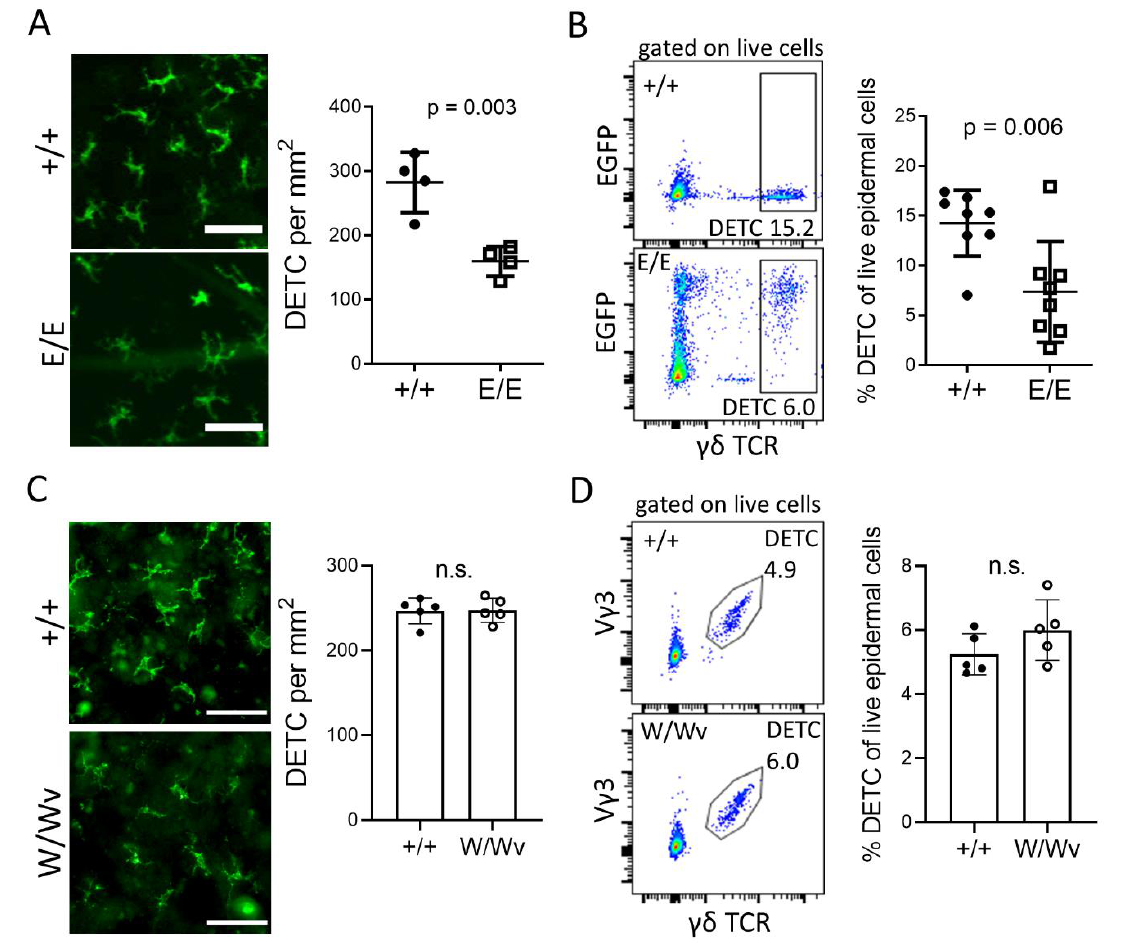
Figure 1. The establishment of dendritic epidermal T cells (DETC) depends on aryl hydrocarbon receptor (AHRR) response, but not on KIT. ( A ) Representative pictures of epidermal earsheets from 10 – 12 weeks old Ahrr +/+ and Ahrr E/E mice stained with anti- Vγ3 -FITC (green) and quantification of DETC on the sheets (scale bar = 50 µm, n = 4 mice) ( B ) FACS-analysis of DETC, stained by γδ TCR-APC in overnight cultivated epidermal cell suspensions of 10 – 12 weeks and 8 – 12 months old Ahrr +/+ and Ahrr E/E mice (20000 events are displayed; 2 experiments, n = 7 – 8 mice) ( C ) Representative pictures of